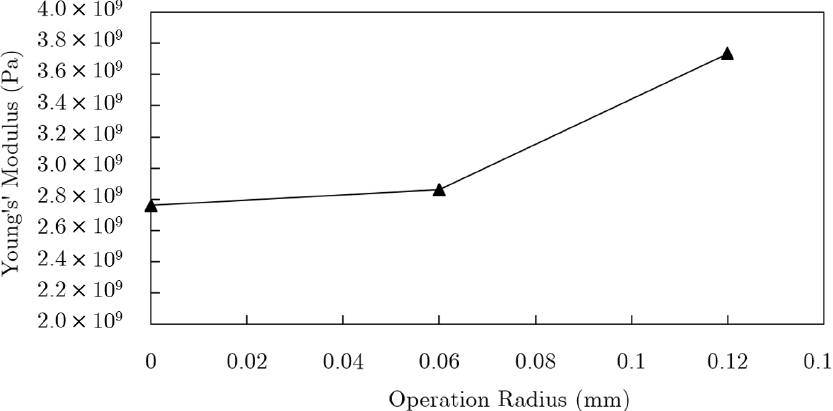
Figure 18. Analysis of the Young’s Modulus with respect to the radius of the closing operation for the closed-cell foam